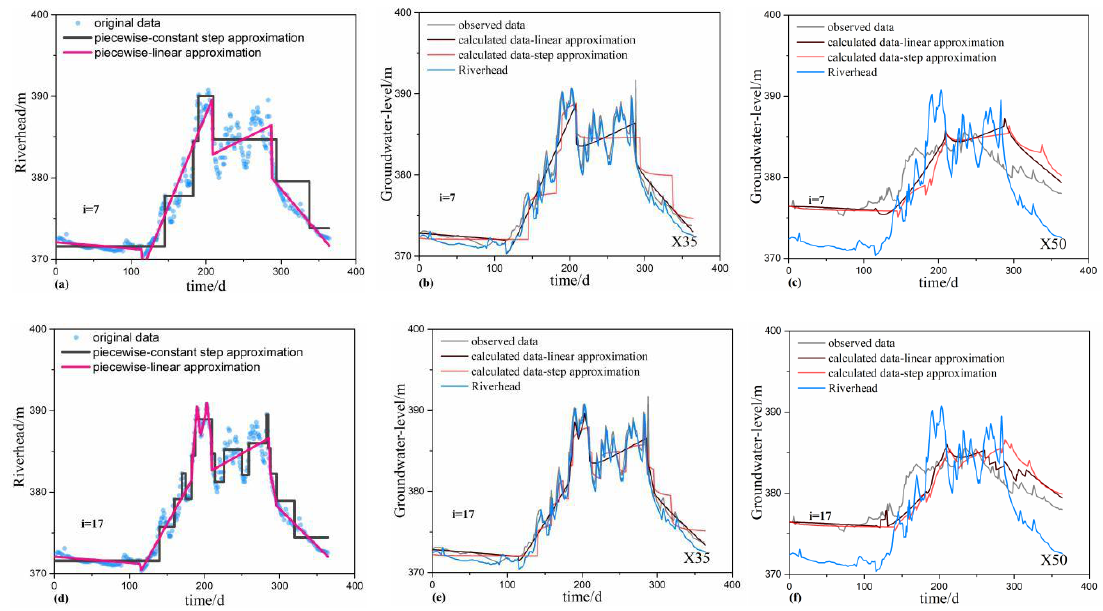
Figure 4. Riverhead variation in 1995 is divided into 7 segments ( a ) and 17 segments ( d ), respectively with piecewise-linear and piecewise-constant step approximations; i is the segments; and calculated results of groundwater-level variation for long-term observation wells X35 ( b , e ) and X50 ( c , f ) with piecewise-linear and piecewise-constant step approximations for different segments.